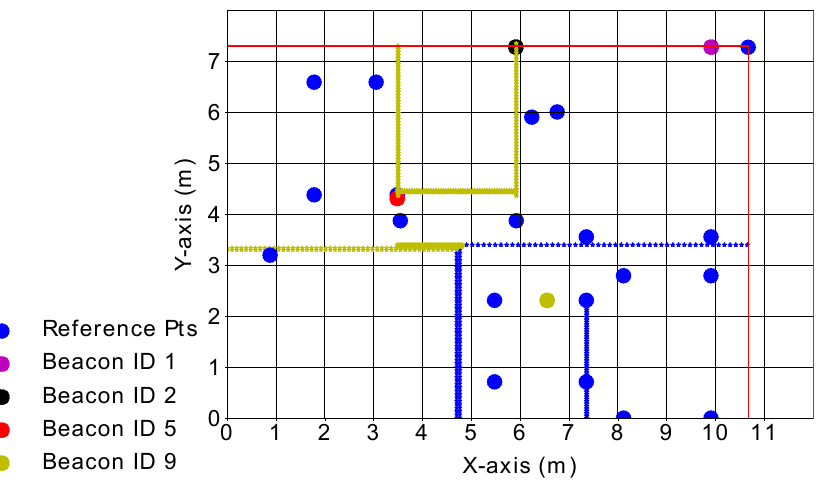
Figure A1. Positions of the anchors (beacons) used for transmitting Bluetooth signals, as well as the reference points where the signal strength was